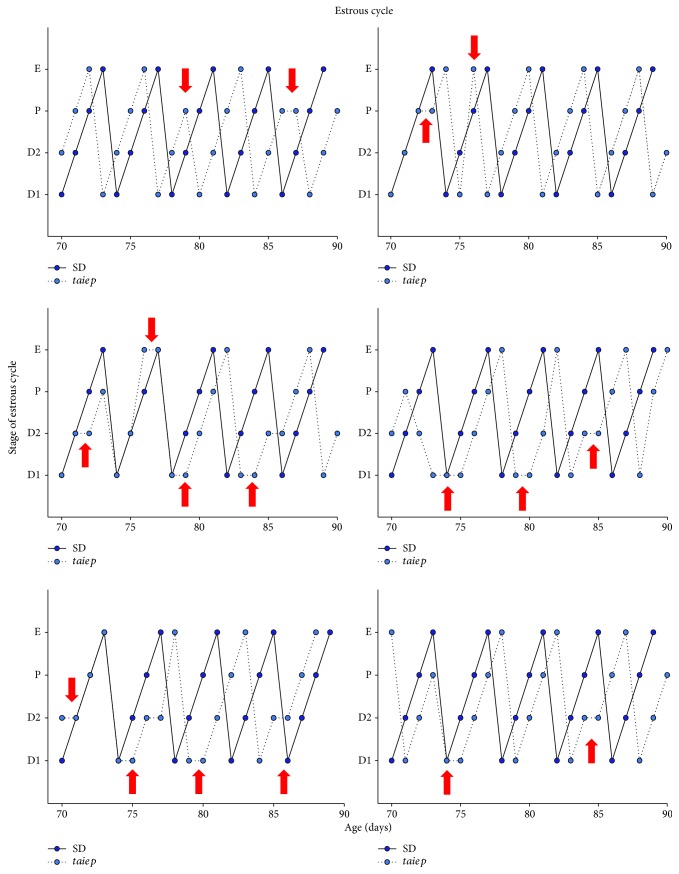
Estrous cycle of Sprague–Dawley and taiep rats from 70 days of age until sacrifice. Each graph represents the estrous cycle of one Sprague–Dawley and one taiep rat. The estrous cycle comprises four stages: estrus, diestrus 1, diestrus 2, and proestus. Red arrows indicate the moments when the estrous cycle of the taiep rat is irregular. SD: Sprague–Dawley; E: estrus; D1: diestrus 1; D2: diestrus 2; P: proestrus.